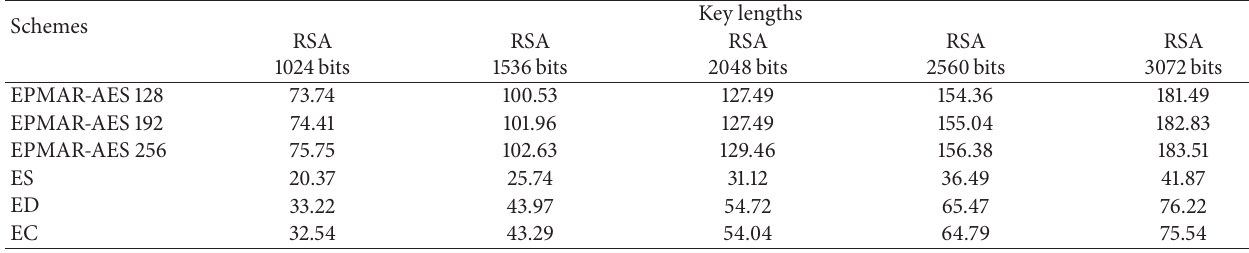
Table 6: Comparison of transmission time for an offline transaction (ms).